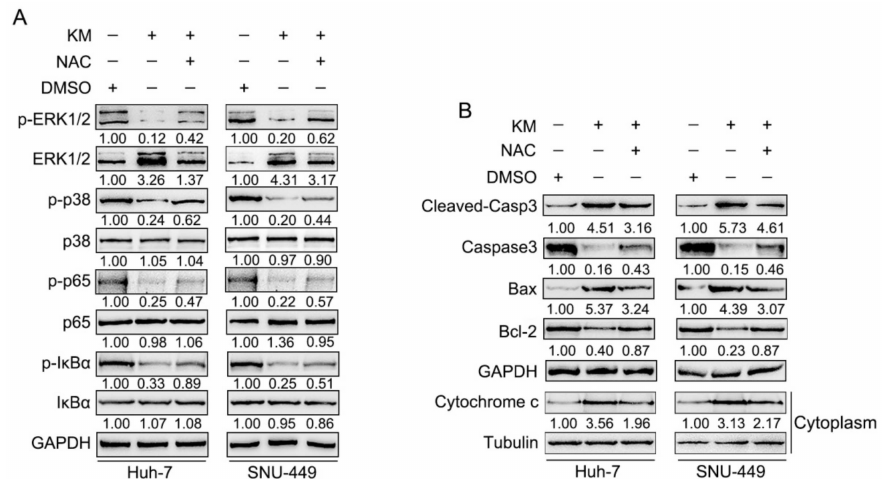
Figure 5. Koumine exerts its e ff ects on HCC cells via ERK / p38 MAPK phosphorylation and NF- κ B signaling. HCC cells were co-treated with 400 µ g / mL koumine and 800 µ M NAC and examined for ( A ) the protein levels of p-ERK, ERK, p-p38, p38, p-p65, p65, p-I κ B α , and I κ B α by immunoblotting; ( B ) the protein levels of apoptosis-related factors, including cleaved-Caspase3, Caspase3, Bax, and Bcl-2 by